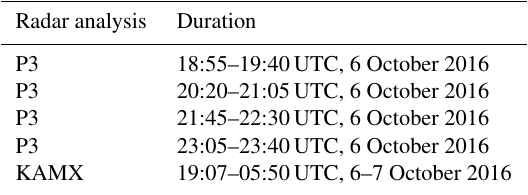
Table 1. Details of the aircraft missions and the corresponding KAMX ground-based radar observation period for this